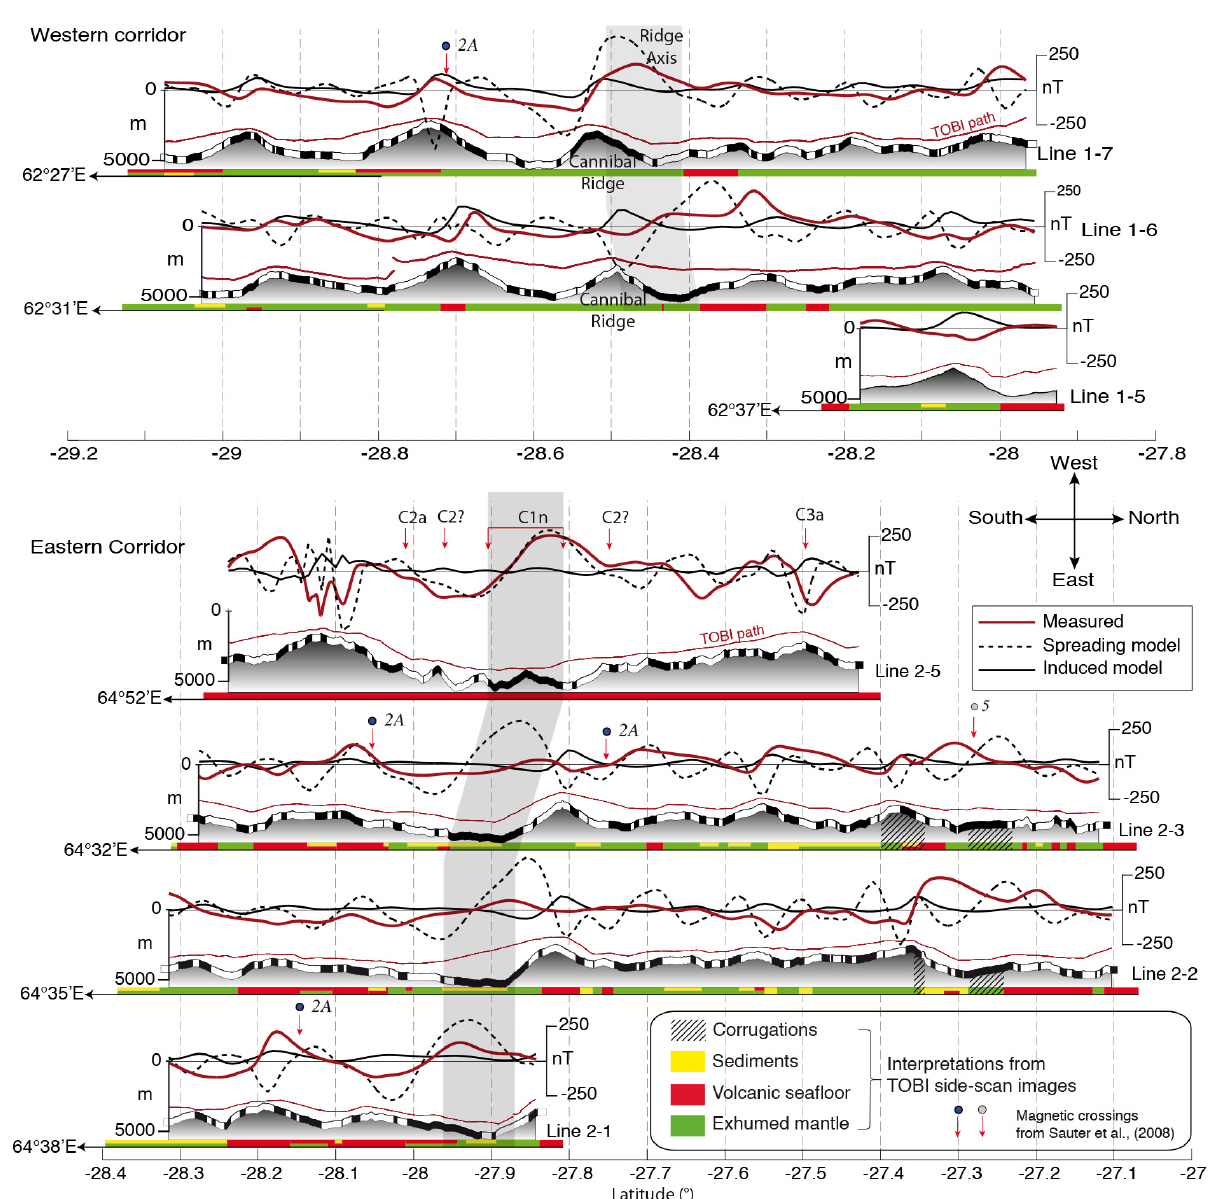
Figure 2. Two-dimensional magnetic profiles recorded within the two survey areas along the profiles shown in Fig. 1. Magnetic data (contin- uous red lines) have been continued upward to a depth of 1200m below sea level. Broken lines correspond to the magnetic anomaly predicted by a 14mma − 1 , seafloor spreading model calibrated on the volcanic seafloor (profile 2–5) with a 500m-thick source layer and a 10 and 5Am − 1 magnetization for the axial and off-axis blocks, respectively. The reversal pattern of the seafloor spreading model is superimposed on the bathymetry. Black solid lines correspond to a model based on a 2km-thick source layer for which an induced and uniform magneti- zation is applied (1.5Am − 1 ). Interpretations from the side-scan images are shown below the bathymetry profiles (from Sauter et al., 2013). The vertical grey area indicates the location of the axial